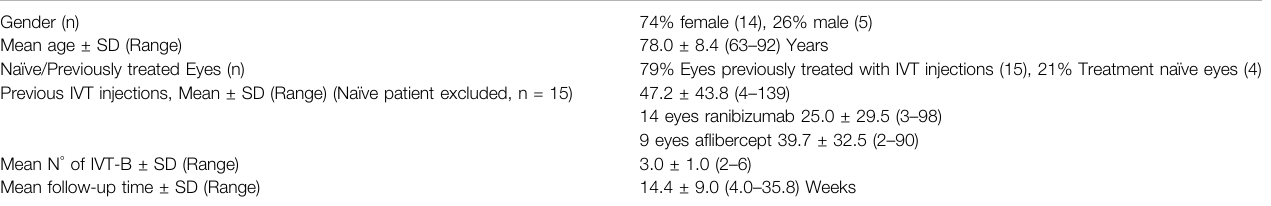
TABLE 1 | Characteristics of the Study Population. Gender